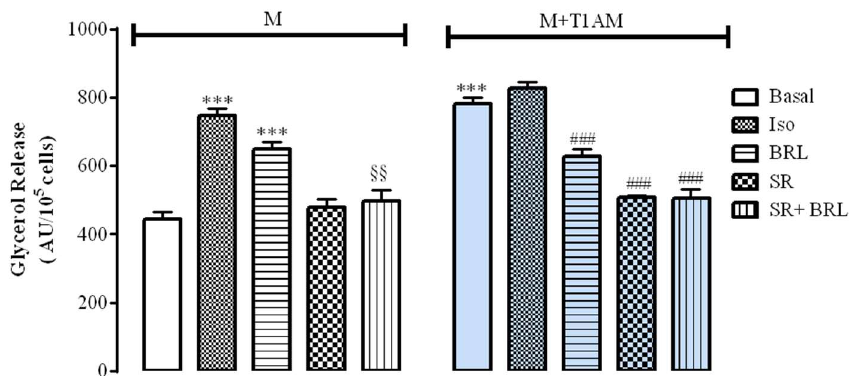
Figure 3. The basal and adrenergic mediated lipolysis in M and M + T1AM cells. The glycerol accumulated in M and M + T1AM cell medium in the absence (basal) or in the presence a not selective beta adrenergic agonist, 1 µ M Isoproterenol (ISO), a selective β 3AR agonist, a selective β 3AR antagonist 0.1 µ M BRL37344 (BRL), 0.1 µ M SR 59230A (SR), or 0.1 µ M BRL and 1 µ M SR was measured fluorometrically as described in the Materials and Methods. Results on the histogram are presented as arbitrary units of fluorescence (AU) / 10 5 cells and represented as the mean ± standard error mean (SEM) values from three di ff erent cell preparations with each point run in triplicate (*** p < 0.001 vs. basal release of M cells; §§ p < 0.01 vs. BRL treatment of M cells; ### p < 0.001 vs. basal release of M + T1AM cells).